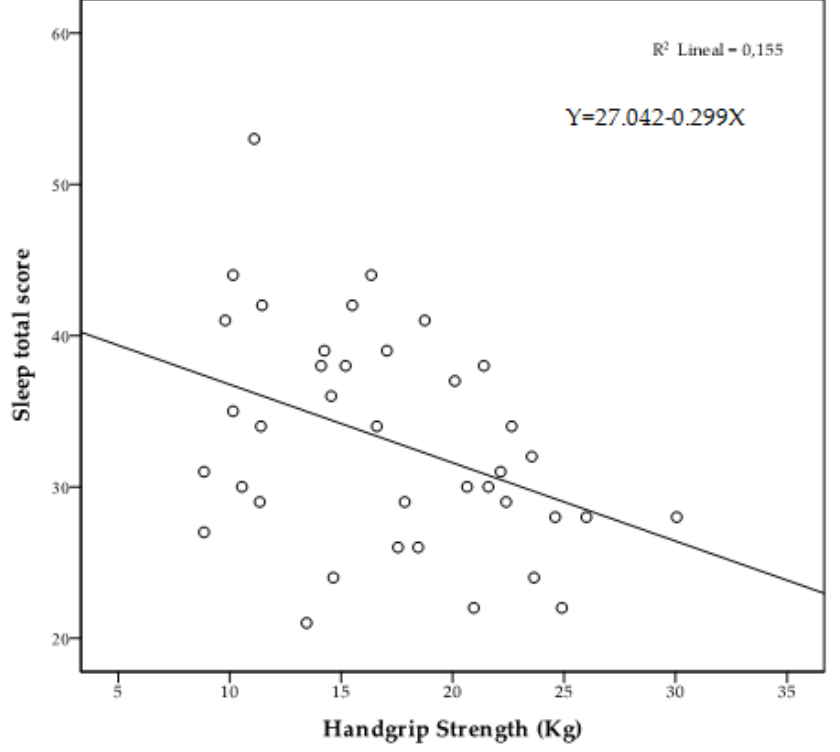
Figure 5. Scatter chart of HGS in relation to sleep total score.